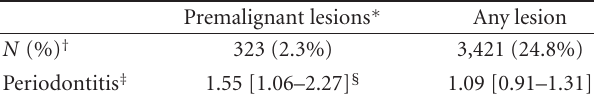
Table 2: Risk of oral premalignant lesions from